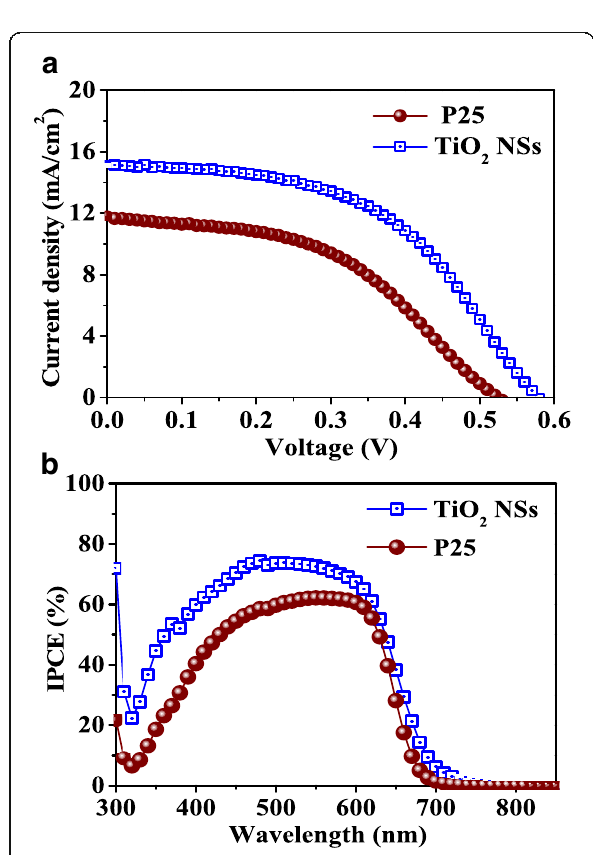
Fig. 5 ( a ) J-V characteristics and ( b ) IPCE spectra of the TiO2 NSs and P-25-based